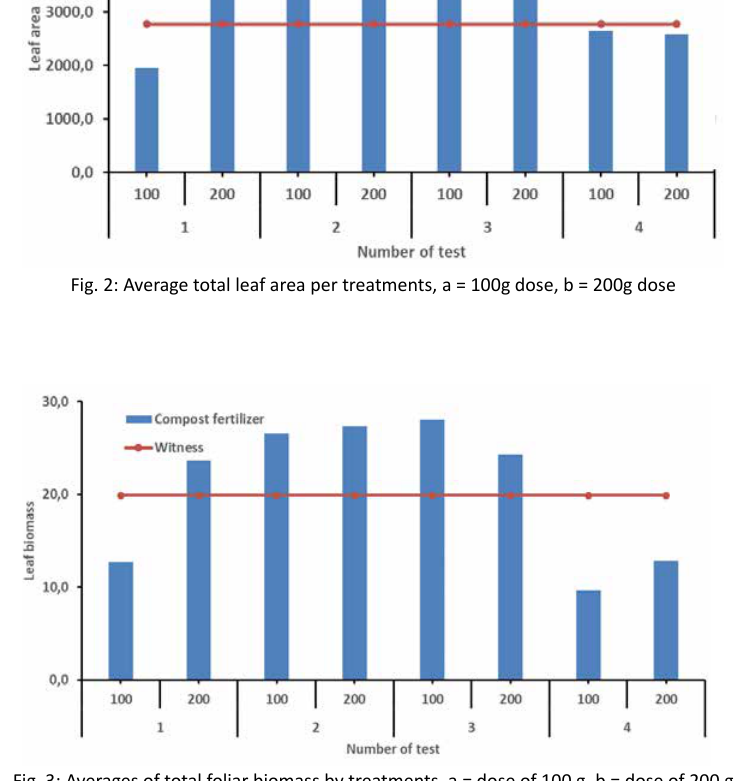
Fig. 3: Averages of total foliar biomass by treatments, a = dose of 100 g, b = dose of 200 g